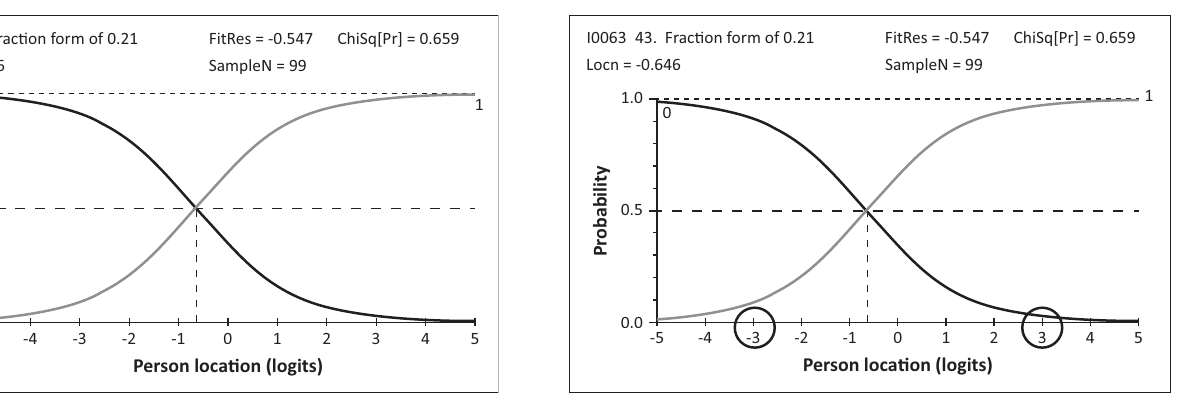
FIGURE 2: Item 63 – category probability curve.